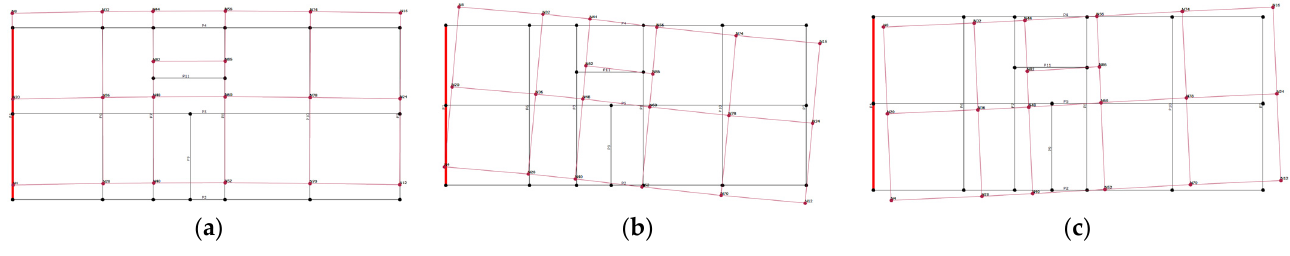
Figure 14. ( a ) First mode; ( b ) second mode; ( c ) third mode.